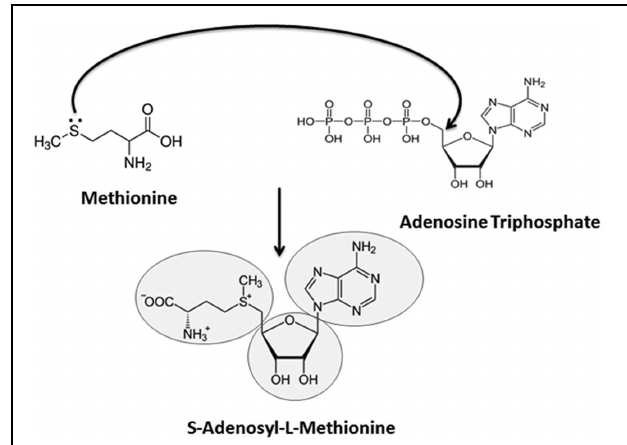
FIGURE 2 | Possible route of S -adenosyl- L -methionine (SAM) appearance and its metabolic significance. The nitrogenous nucleobase ‘adenine,’ present in the universal methyl donor cofactor SAM, could have been generated by an electric spark reaction in an aqueous solution of NH 3 and HCN (in fact, adenine is merely a pentamer of HCN). The base is highly conspicuous in all life forms in the form of the high energy molecule, Adenosine Triphosphate (ATP), which is the universal energy currency of cells. Likewise, methionine has been reported to be synthesized from a mixture of CH 4 , H 2 S, NH 3 , and CO 2 by providing a similar electric discharge (Van Trump and Miller, 1972; Parker et al., 2011). Methionine is the first amino acid decoded by the genetic code into the biotic proteins. Finally, the ribose sugar present in SAM can be synthesized from formaldehyde by formose reaction using basic substances, neutral clays, heat and various types of radiation. Ribose is the first sugar formed in the anabolic reactions while deoxyribose is synthesized later. Nucleophilic addition reaction of methionine with ATP produces the SAM cofactor, which represents the second most abundant molecule (after ATP) inside all cells and participates in all methylation